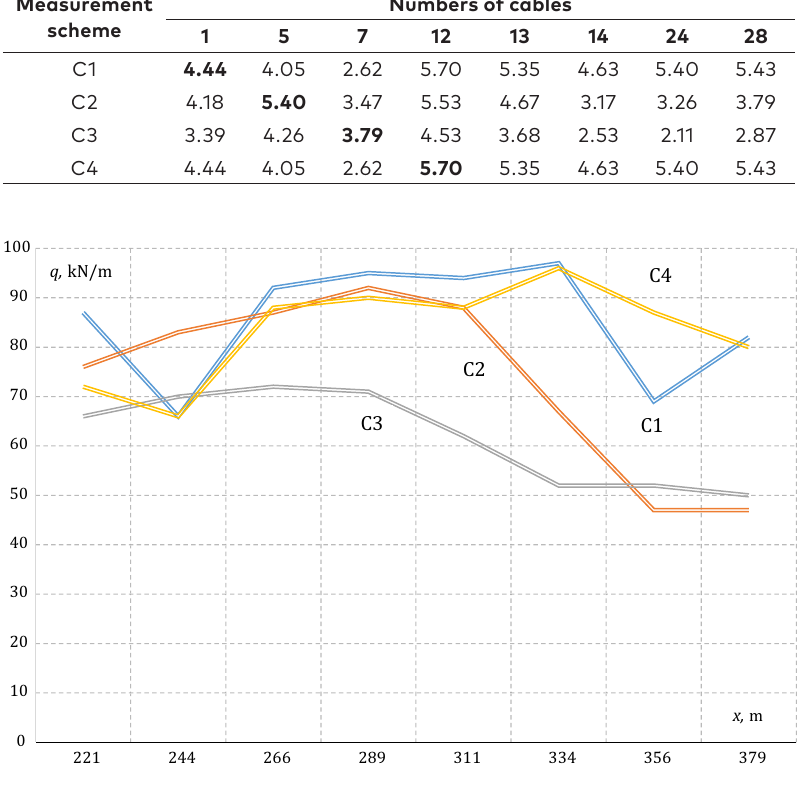
Figure 10. The distribution of the load of the central part of the main span during traffic congestion (successive schemes C1, C2, C3,